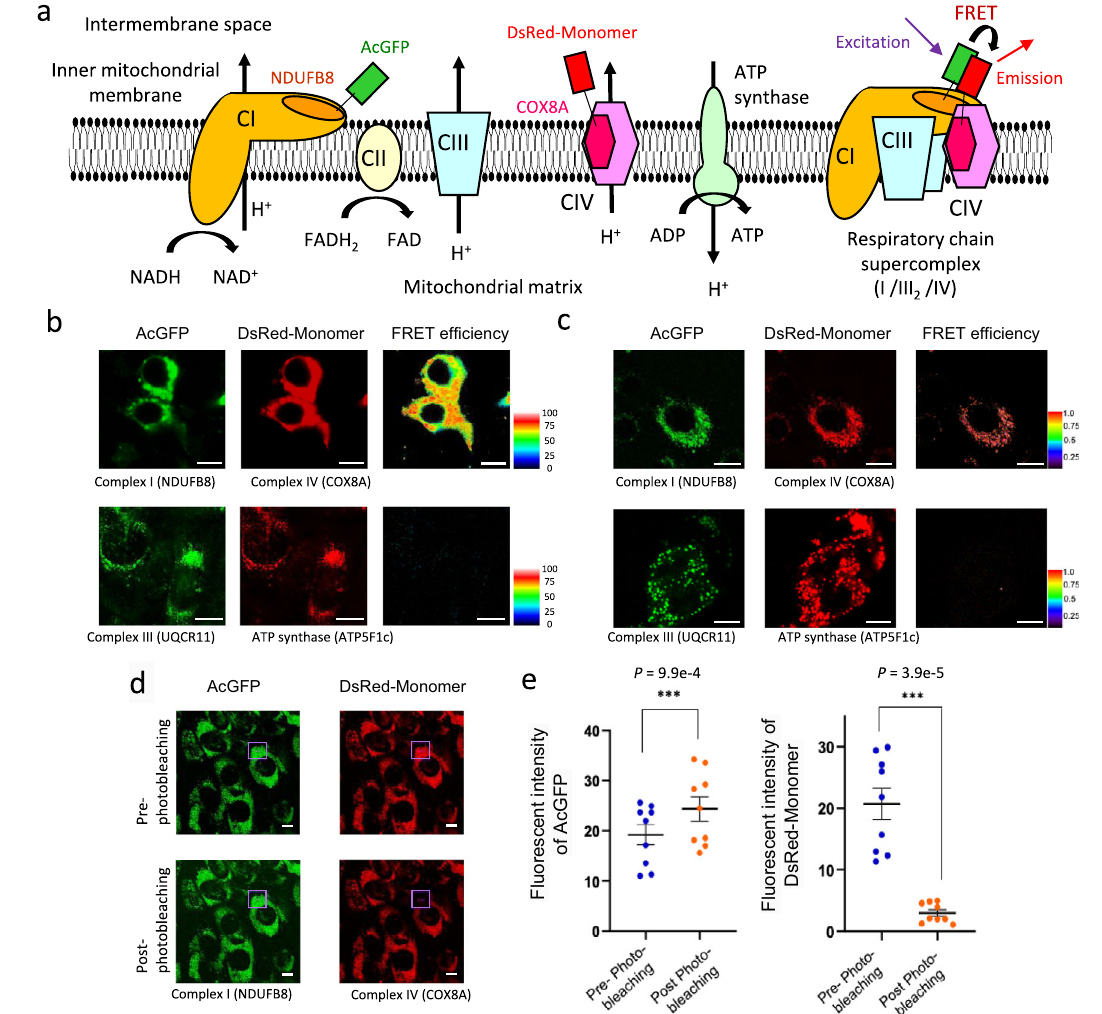
Fig. 1 | Intermolecular FRET biosensors of mitochondrial respiratory chain complexdetectsupercomplexformationin fi xedandlivecells.a Schemaof fi ve molecularcomplexesinvolvedinoxidativephosphorylation;complexI – IVandATP synthase. A subset of mitochondrial respiratory chain complexes forms a higher- orderstructurecalledsupercomplex.Themostabundantsupercomplexconsisting of complex I (CI) monomer, complex III (CIII) dimer, and complex IV (CIV) mono- mer (I/III 2 /IV) is shown. Förster resonance energy transfer (FRET) biosensors of AcGFP tethered to NDUFB8 (a subunit of CI) and DsRed-Monomer tethered to COX8A(asubunitofCIV)areshown. b , c FluorescencemicroscopyimagesofC2C12 myoblasticcellsstablyco-expressingNDUFB8-AcGFPandCOX8A-DsRed-Monomer (upper panels), and UQCR11-AcGFP and ATP5F1c-DsRed-Monomer (lower